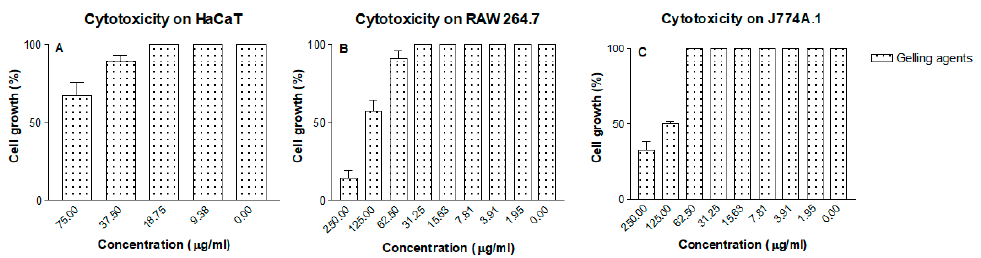
Figure 8. Cytotoxicity of the gelling excipients in cell lines ( A ) HaCaT, ( B ) RAW 264.7 and ( C ) J774A.1. Pharmaceutics 2019 , 11 , x FOR PEER REVIEW 11 of 16